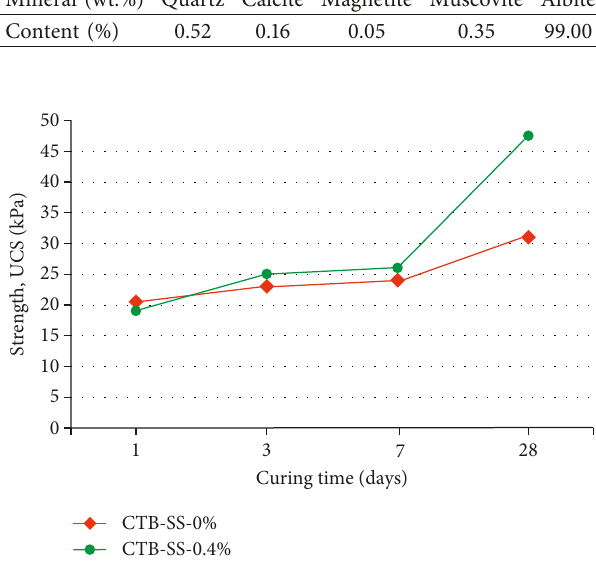
Table 3: Main mineral compositions of the tailings used. Mineral (wt.%) Quartz Calcite Magnetite Muscovite Albite Content (%)